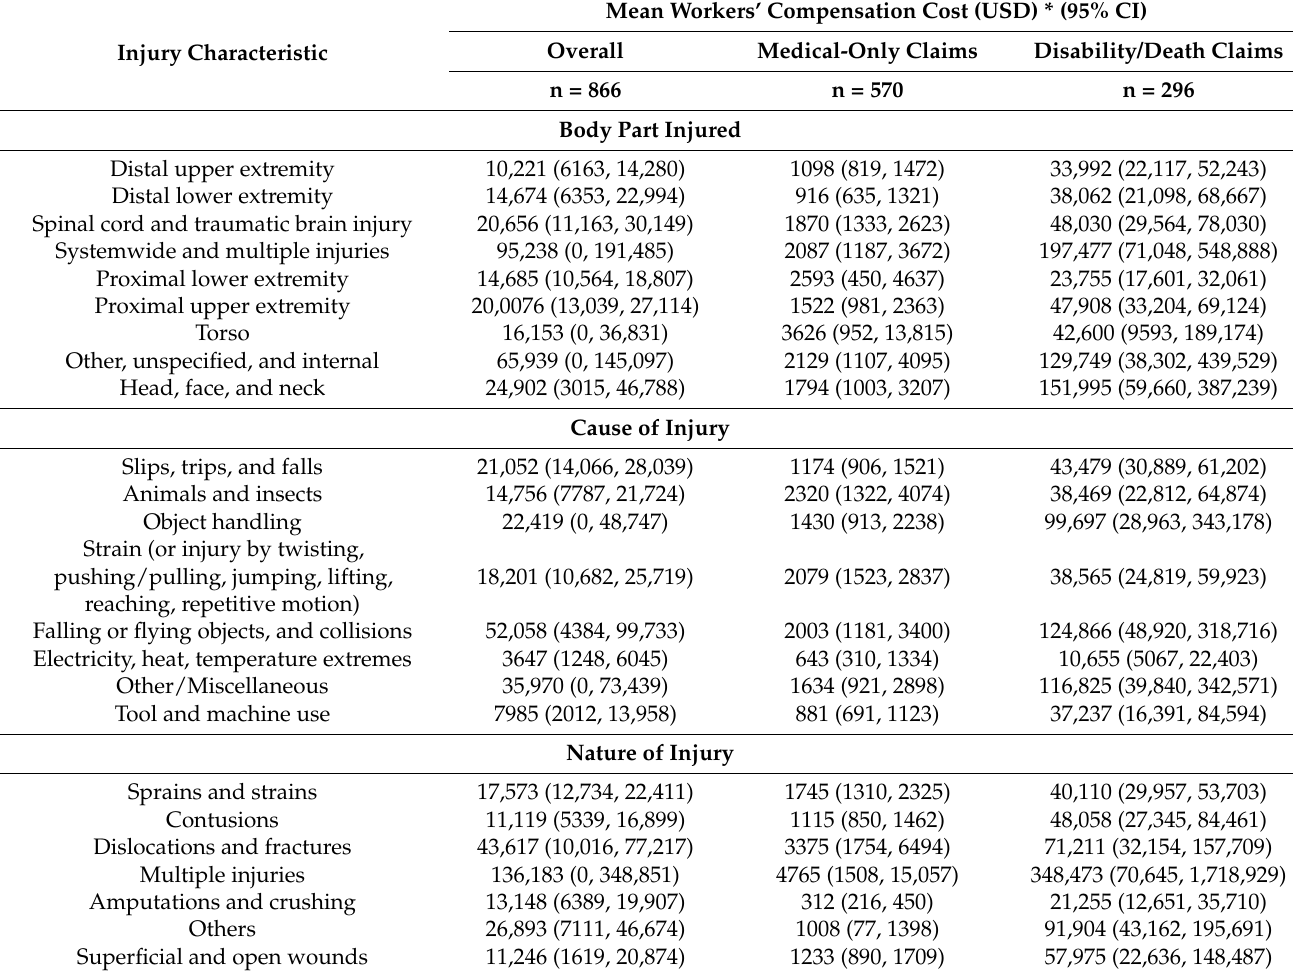
Table 4. Total cost incurred for WC payable claims by claim type (n = 866).